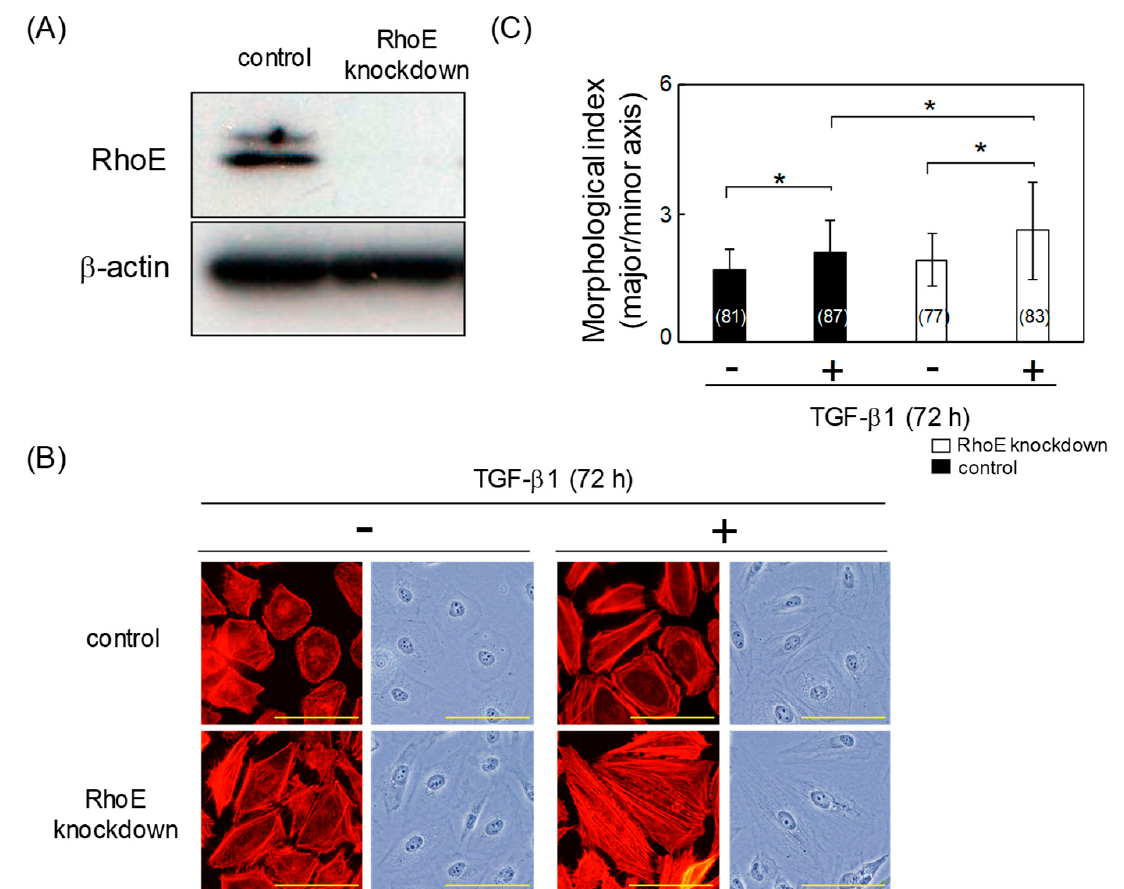
Figure 2. RhoE knockdown increases the degree of cell elongation in HeLa cells treated with TGF- β 1. ( A ) Knockdown efficiency of RhoE in HeLa cells. HeLa cells were transfected with